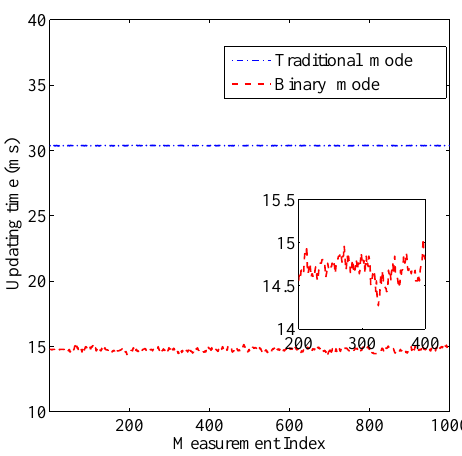
Figure 9. Updating time in the traditional mode and the binary mode.